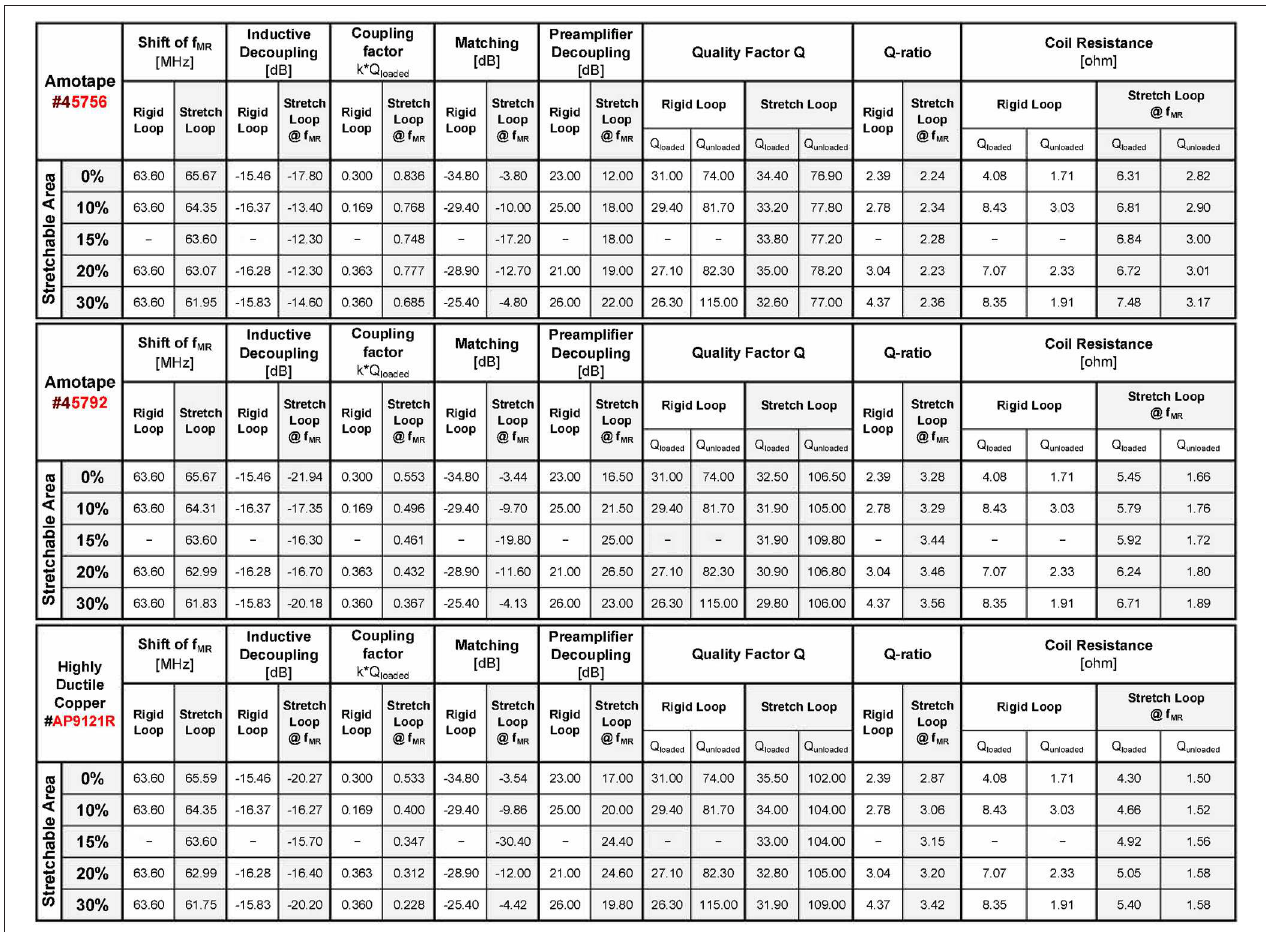
FIGURE 11 | All measured values in the laboratory of each double-loop using the materials described in Table 2 (except CuBe 2 strain springs) with the experimental setup described in Figure 1D